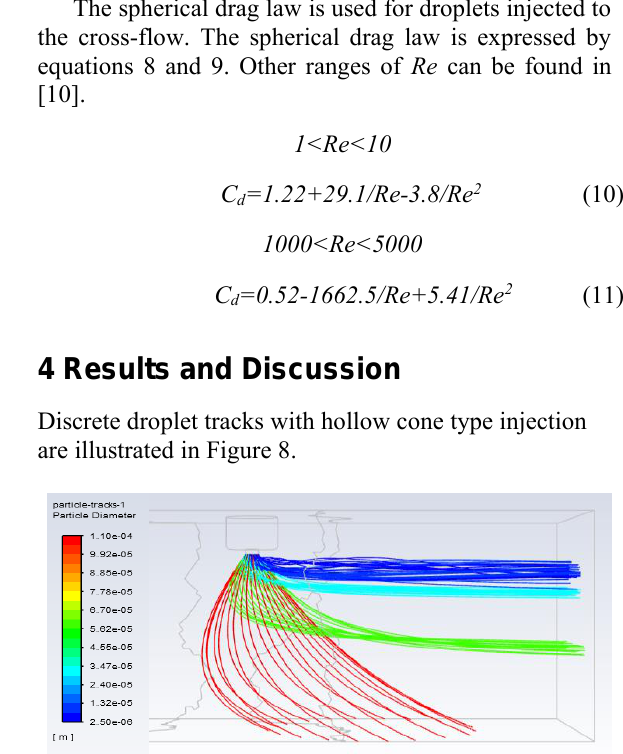
Fig. 8. Discrete droplet tracks for hollow-cone type injector for 8